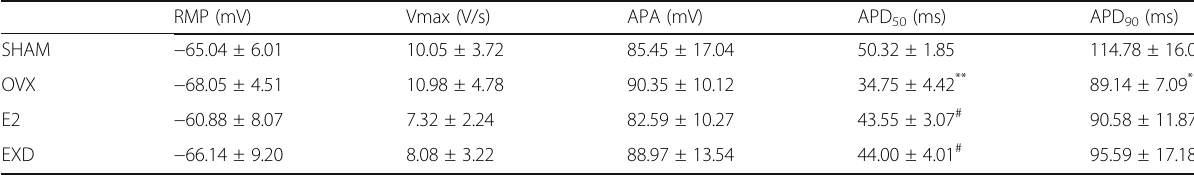
Table 1 Effect of EXD on ventricular action potentials